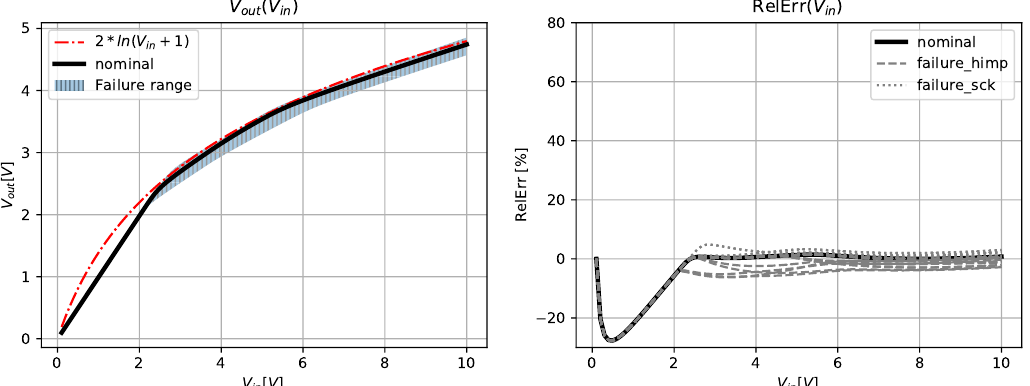
Figure 10. The voltage response of the resulting failure-resilient natural logarithm circuit. ( Left ) The complete output range, where the red (dash-dot) curve represents the ideal natural logarithm function, the black (solid) curve represents the failure-free circuit, and the gray area represents the range of responses with all possible single diode failures. ( Right ) Relative deviations from the ideal − 2ln ( V in + 1 ) ) . Stuck-open failures are drawn in natural logarithm function ( RelErr ( V in ) = V out max ( V out ,2ln ( V in + 1 )) dashed lines while stuck-short failures are drawn in dotted